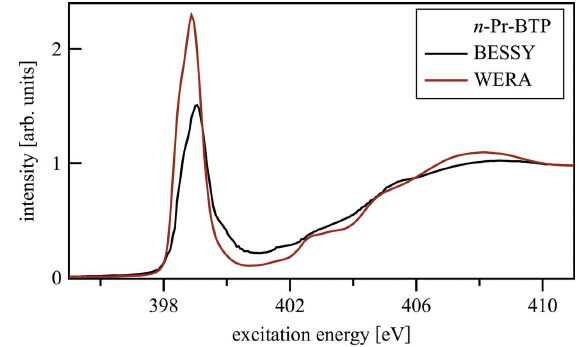
Figure 16 N K -edge spectra of n -Pr-BTP measured in PEY at the UE52-PGM beamline at BESSY and at the WERA beamline at